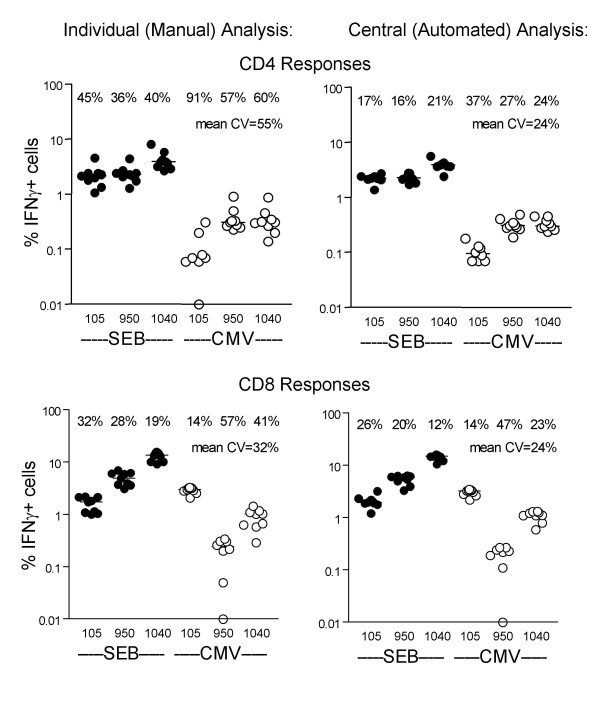
Results of Experiment 1 (fixed activated whole blood). IFNγ-positive cells in response to SEB or CMV pp65 peptide mix are expressed as a percentage of CD4+ or CD8+ T cells. Results from each site are indicated as a circle, with median responses for each sample (105, 950, and 1040) indicated by a horizontal bar. The C.V. for each sample is listed across the top of each panel, along with the mean C.V. for that set of samples.